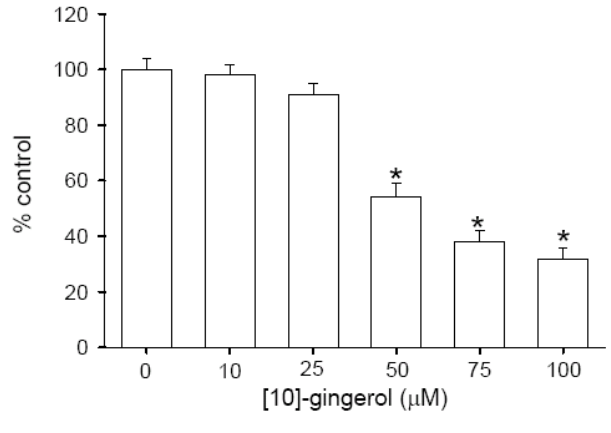
Figure 6. Cytotoxic effect of [10]-gingerol on human colorectal cancer SW480 cells. The cell viability was determined by the trypan blue exclusion (TBE) method. Data are expressed as the percentage of control ([10]-gingerol was